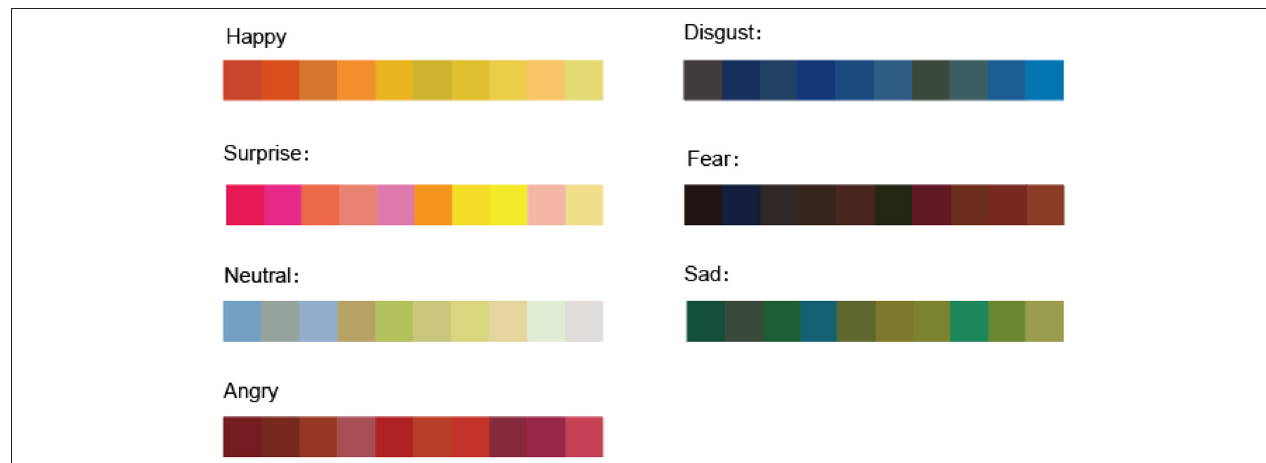
FIGURE 3 | Emotional palette.